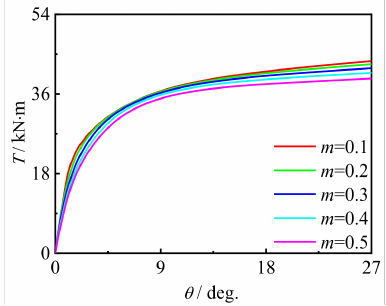
Figure 24. Effect of m on T - θ